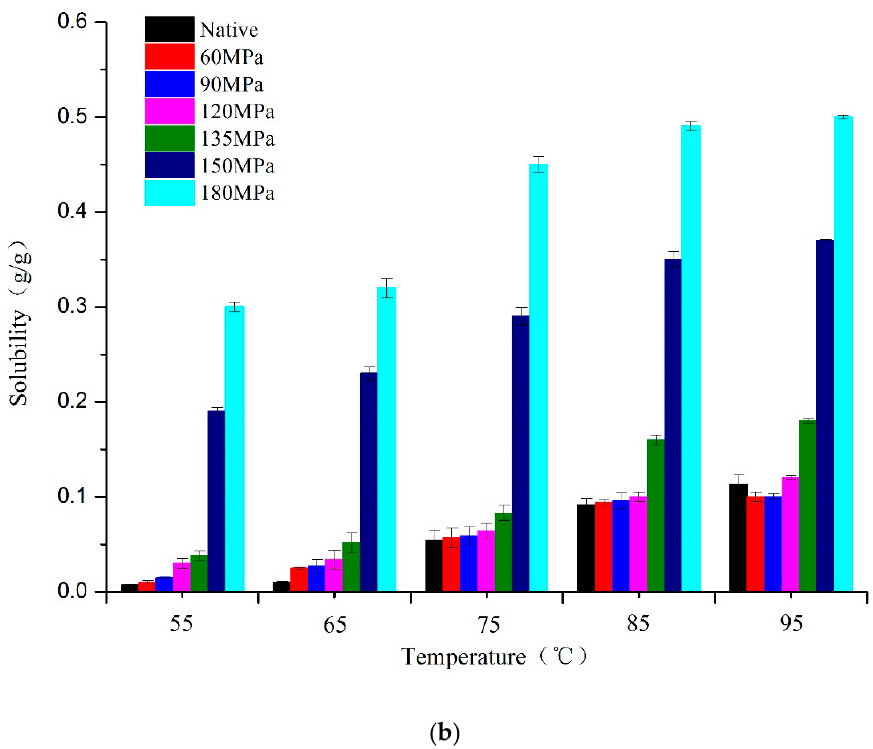
Figure 4. Swelling power ( a ) and solubility ( b ) of native and pressurized LS. The average size distribution of starch particles under different HPH conditions is shown in Table 1.